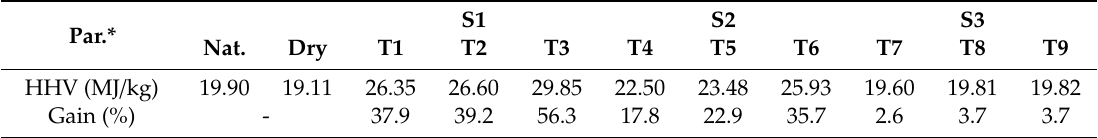
Table 4. Results for calorific value for Series 1, 2, and 3.